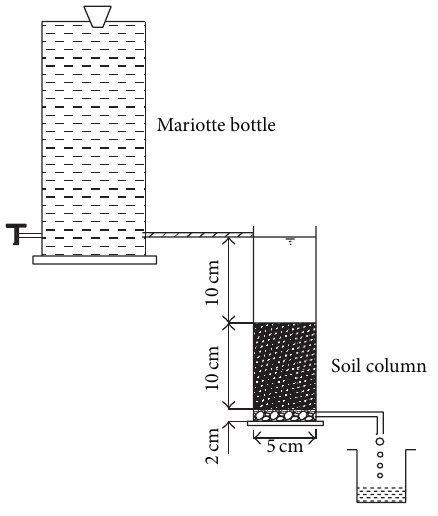
Figure 1: Experimental device of Ca 2+ penetration. Table 1: Physical and chemical properties of the soil.